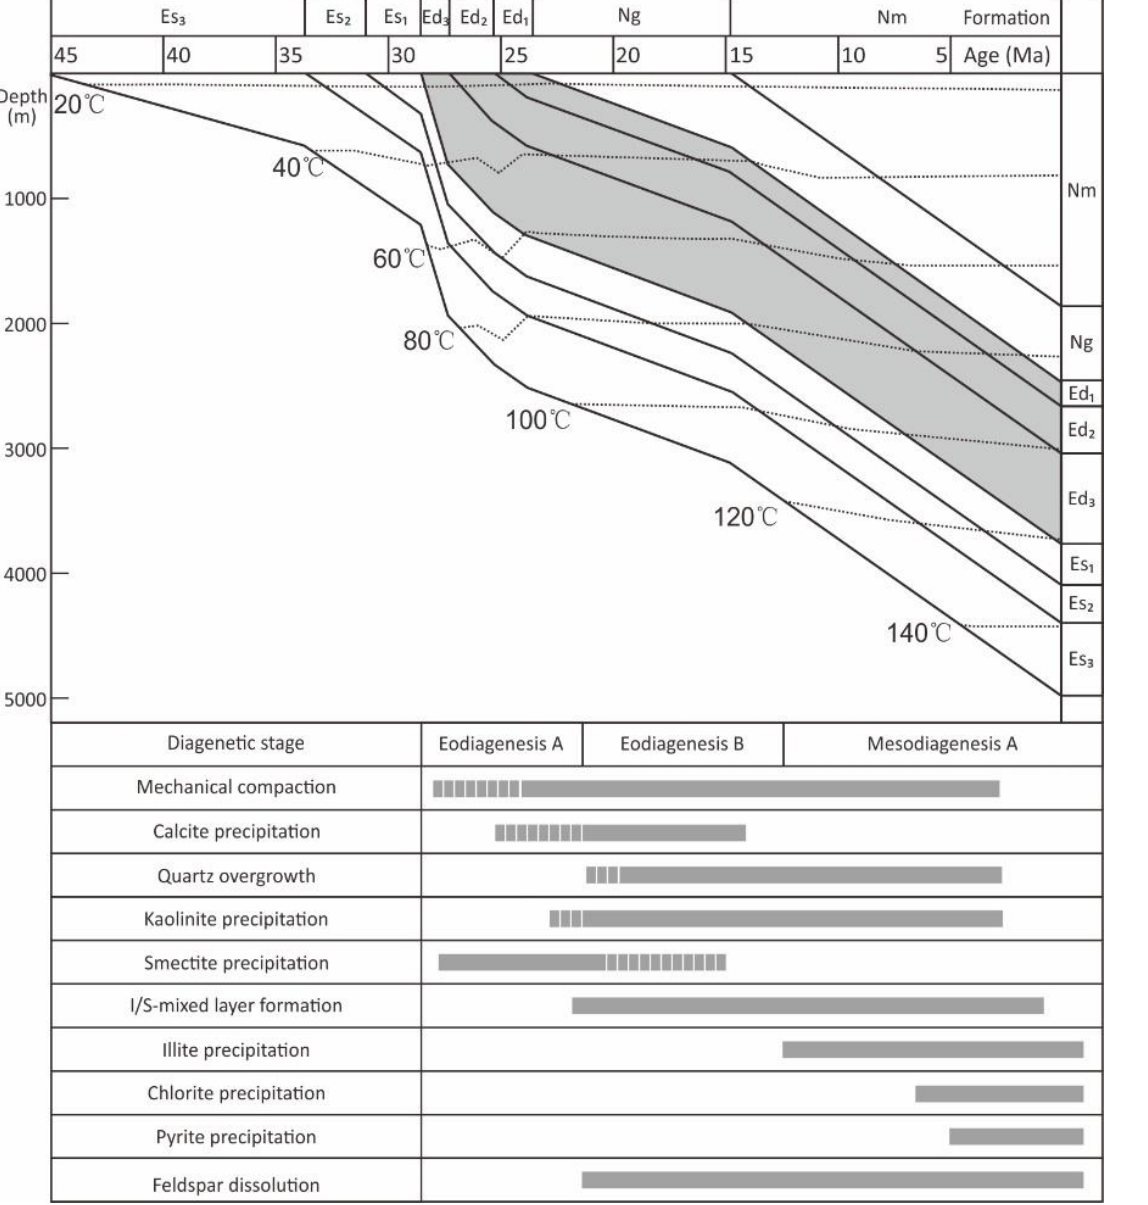
Figure 14. Burial history diagrams of well Np1 and diagenetic sequence of sandstones from the Eocene Dongying Formation (Ed) in the No. 1 structural belt [62].